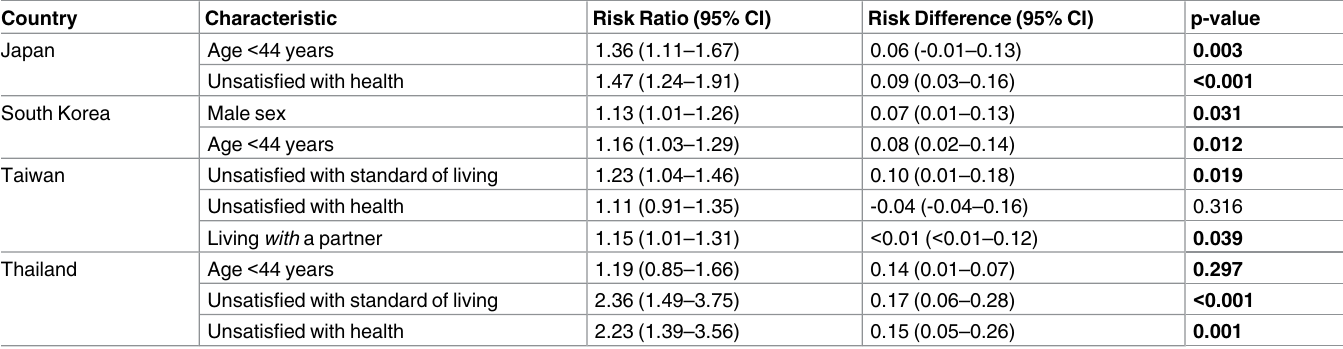
Table 6. Multivariate regression models for lower trust (trust ‘not at all’ or ‘not much’) in Judicial/Legal System in each country. Country